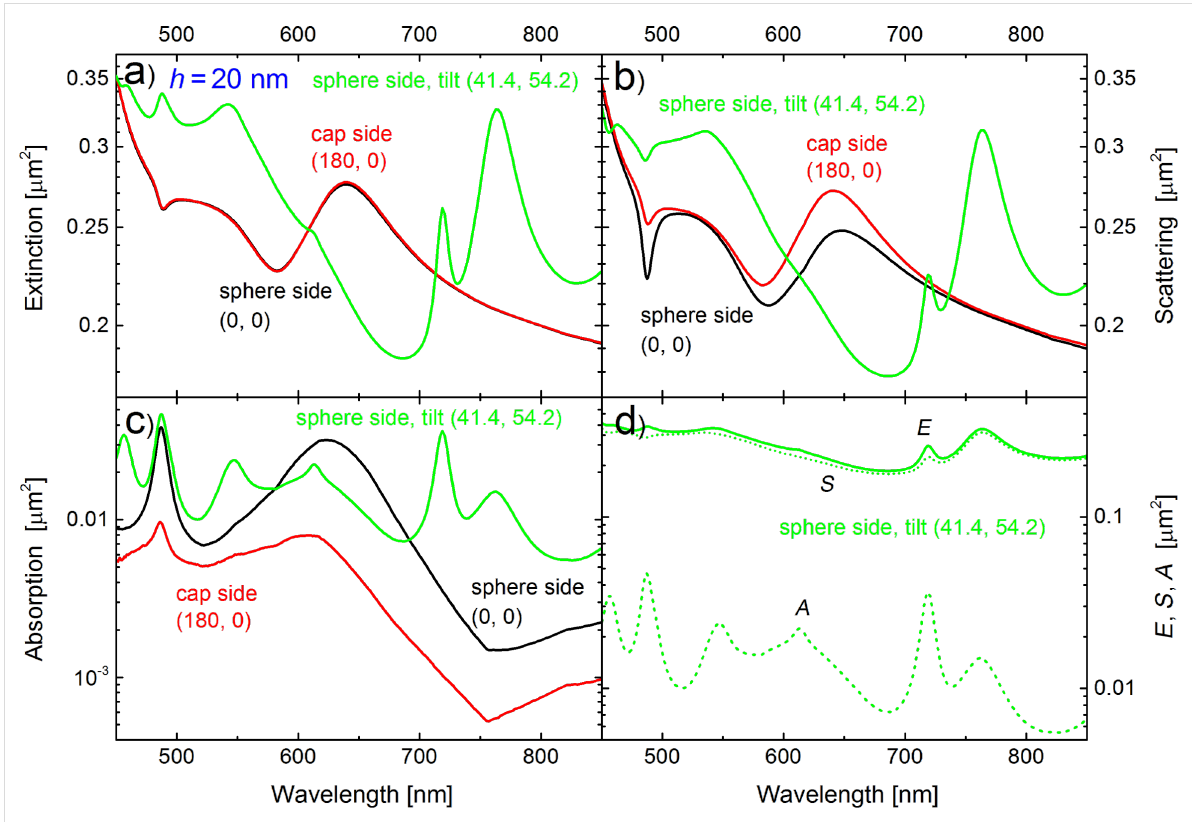
Figure 4: Dependence of the cross sections of the semi-shell structure with a core diameter d = 390 nm and a Ag thickness h = 20 nm on the direc- tion of irradiation. Illumination from the open sphere side (0,0) (black curve), or from the Ag-capped side (180,0) (red curve), or from the sphere side with the plane wave impinging under the oblique angels θ = 41.4°, φ = 54.2° with the electric field in the x–z plane (green curve). Other parameters and notations are the same as in Figure 1. Illumination under oblique angles leads to many more resonances because of the loss of degeneracy by cylindrical